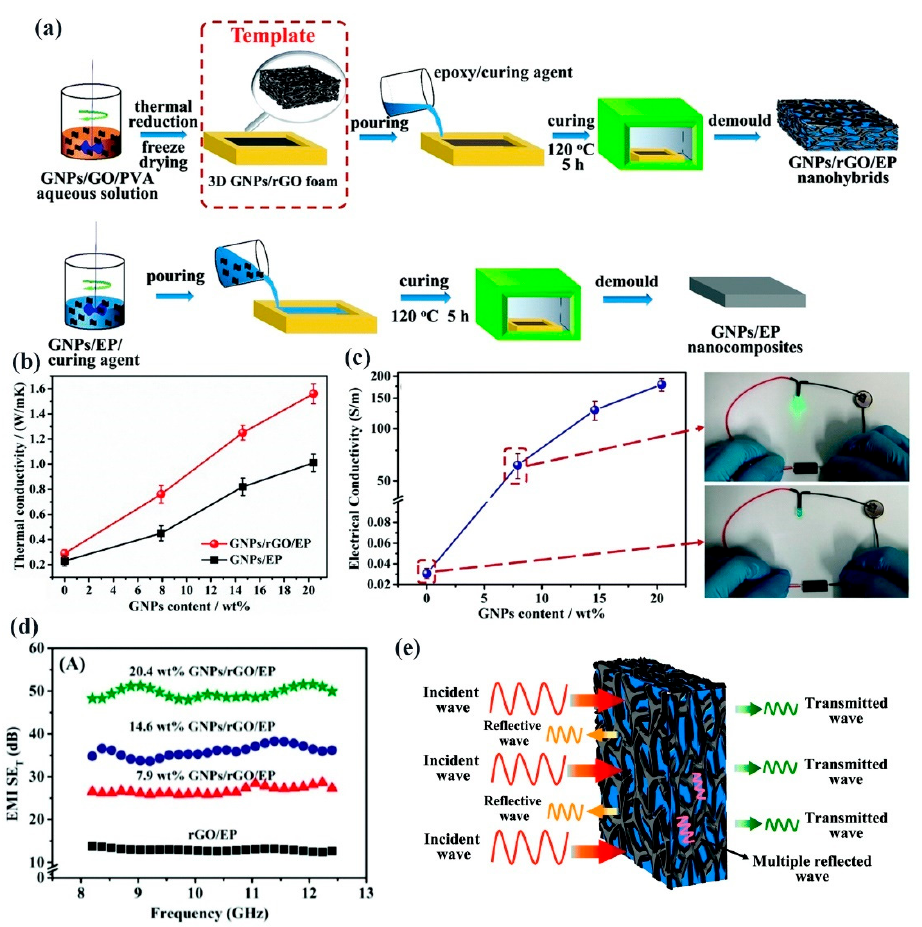
Figure 4. ( a ) Schematic diagram for the fabrication of 3D graphene nanoplatelets (GNPs)/reduced graphene oxide (rGO)/EP and GNPs/EP nanocomposites. ( b , c ) Effect of the GNP content on the thermal and electrical conductivity. ( d ) Electromagnetic interference shielding (EMI SE) of the rGO/EP and 3D GNPs/rGO/EP nanocomposites at the X-band. ( e ) Schematic of the electromagnetic wave transfer across the 3D GNPs/rGO/EP nanocomposites (reproduced with permission from [109]).